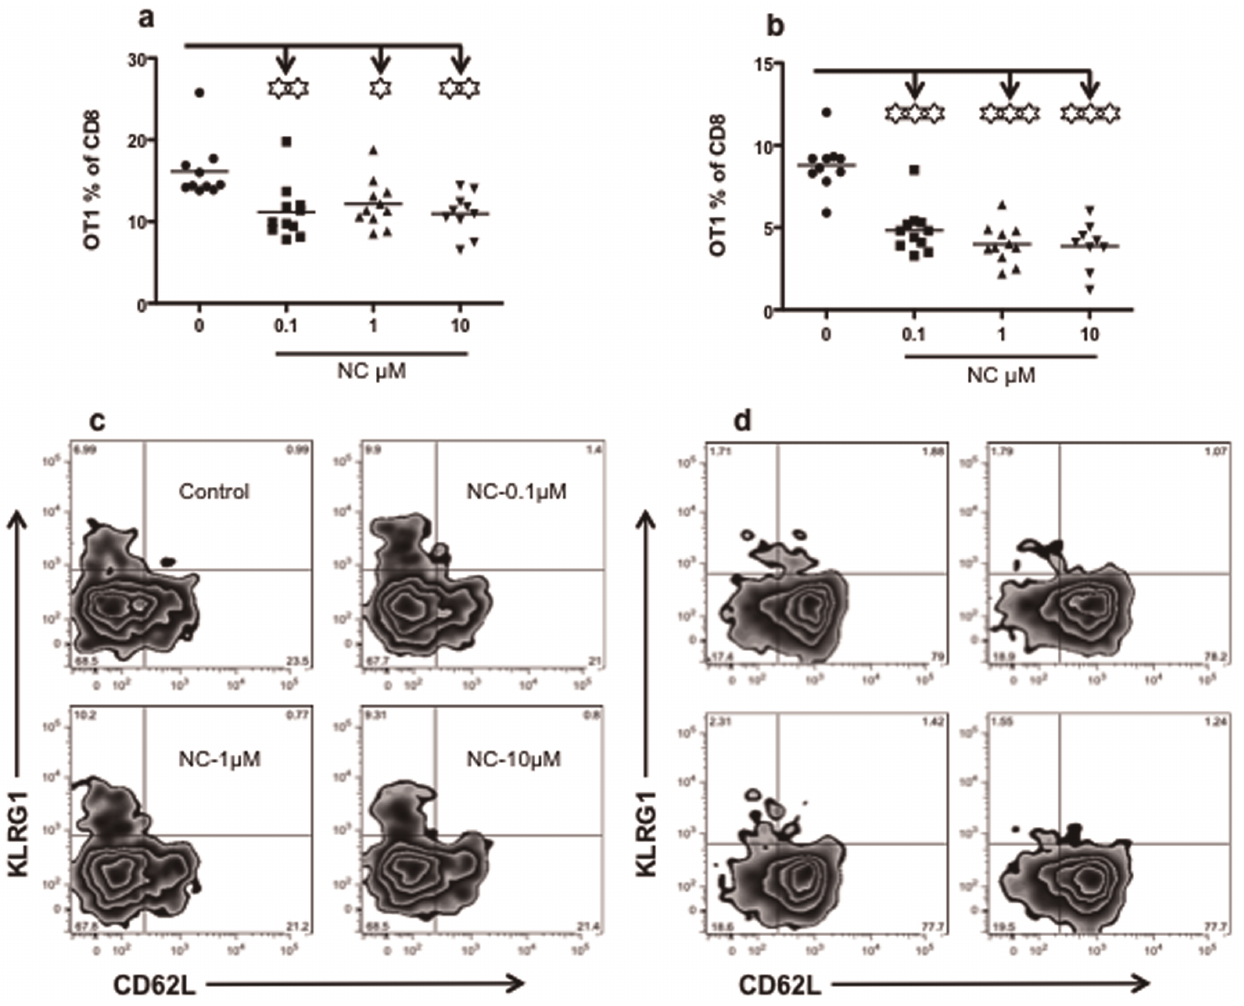
Figure 3. Nicotine reduces CTL expansion after transfer into recipients. Purified OT-I cells were cultured for 3 days with 3SI in the presence of nicotine at different concentrations. Three days after stimulation, CTLs were harvested and transferred into B6 recipients at 10 6 cells/mouse. A–B. Comparison of percentage of OT-I cells in total CD8 cells in blood at day 5 (A) and 14 (B) post transfer. C–D. Comparison of the phenotype of OT1 cells in blood from mice at day 5 (C) and 14 (D) post transfer. Data are obtained from one experiment with 10 to 11 mice per group. Asterisks indicate statistical significance. *, P , 0.05; **, P , 0.01; ***, P , 0.001.